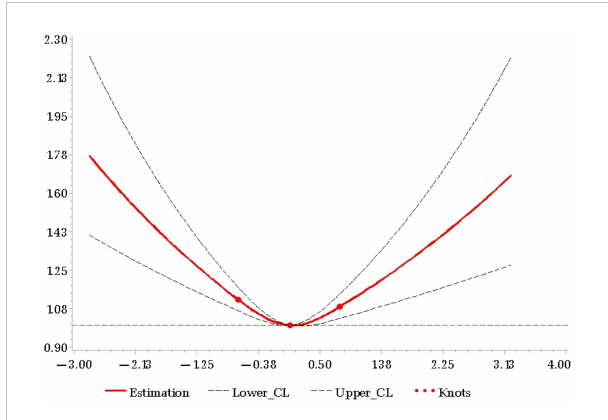
FIGURE 3 HR of CMDs and TyG-index change adjusted for all covariates.